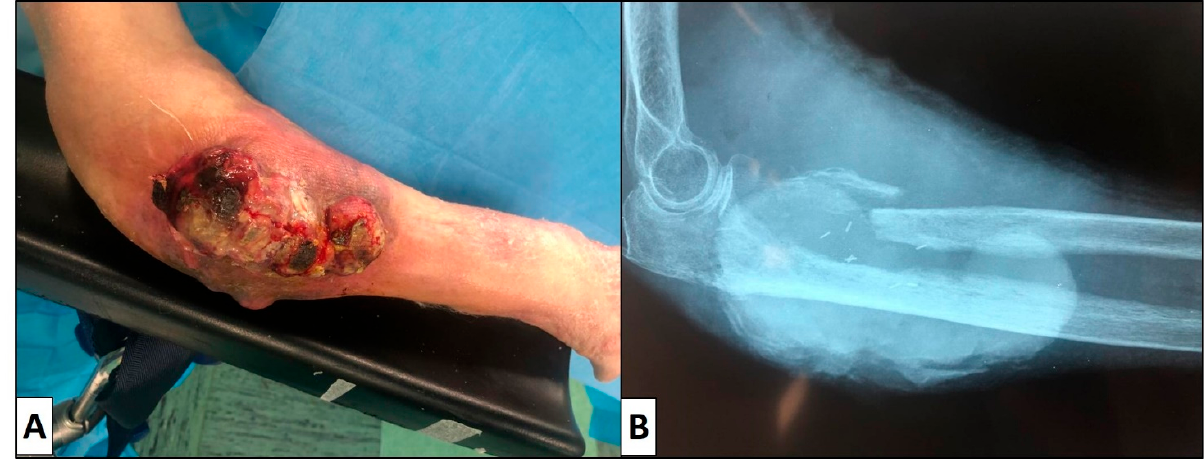
Figure 1. Ulcerated cutaneous lesion ( A ). Radiographic image ( B ) shows a big lesion of soft tissue that has infiltrated underlying bone plans, in particular proximal radio, which is almost completely eroded. The proximal ulna also appears infiltrated and partly rare.